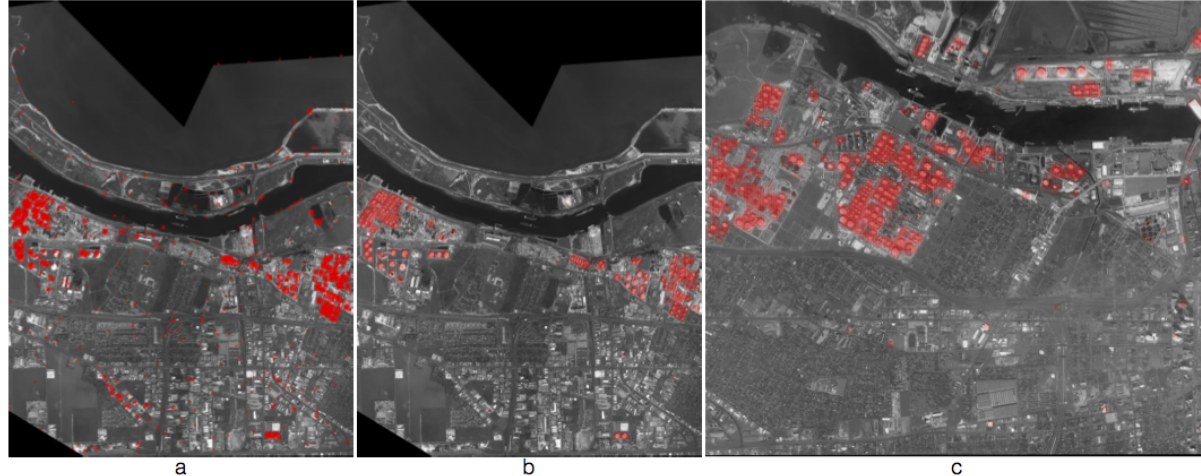
Figure 7: Detections in the Corpus Christi data set. Image (a) shows the results of the initial model on the validation image. Image (b) shows the results after the bootstrapping process on the same validation image. Image (c) shows the results of the final model on a withheld test